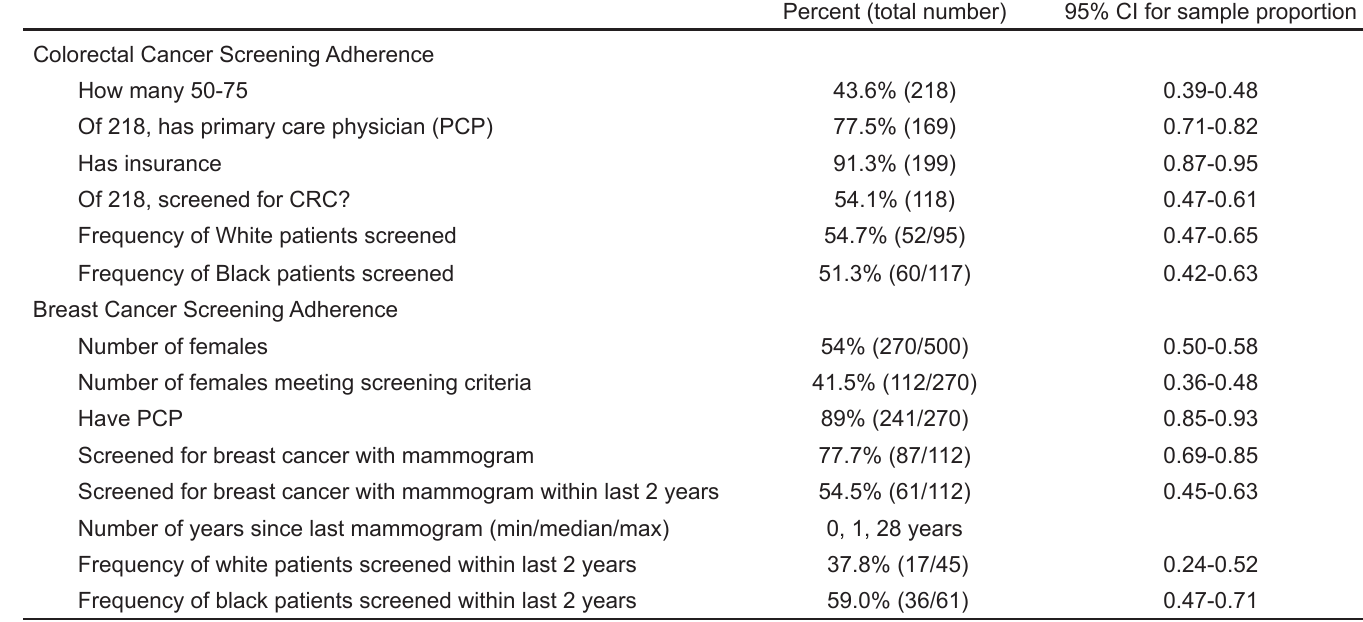
Table 3. Adherence to colorectal and lung cancer screening guidelines.